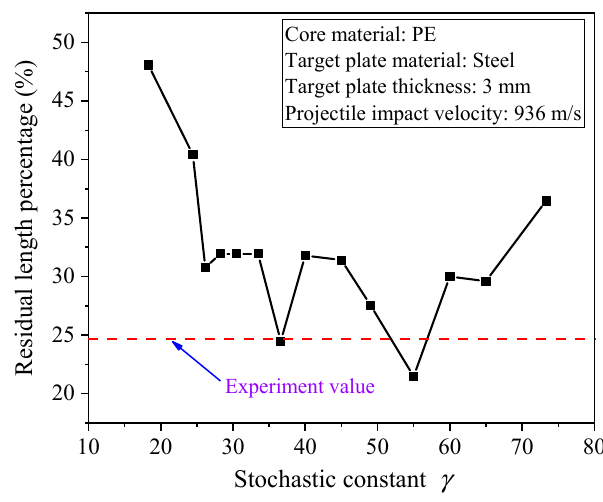
Figure 12. Trial results under different γ values.